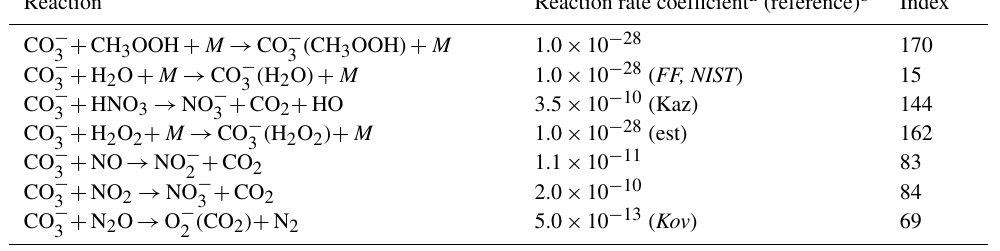
Table A2. Ion-neutral reactions sorted alphabetically by reagent ion first and then by neutral species ( M denotes a third body reactant, N 2 or O 2 )